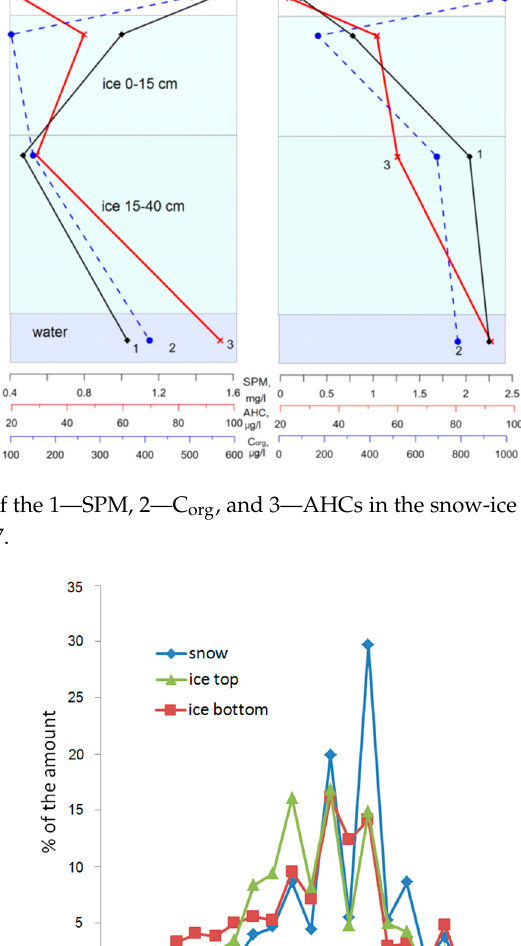
Figure 7. Composition of the alkane in snow, ice, and ice water of Pikalevo Lake, 2017.